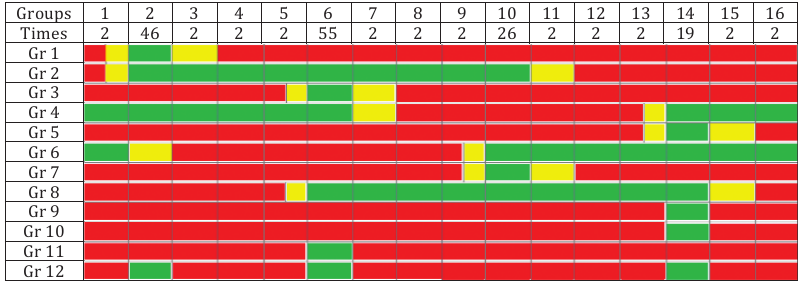
Gr 12 Figure 11. Software Output and intergreen times of roundabout in 2016